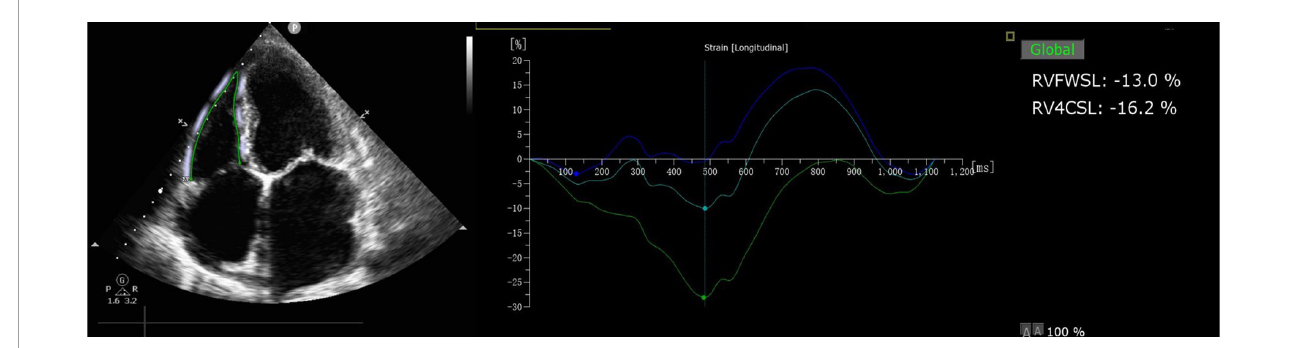
FIGURE2 RVFWSL and RV4CSL analysis. Offline analysis was performed using QLAB 10.3 software (cardiac motion quantification; Phillips Medical Systems) to analyze the longitudinal myocardial strain in the right ventricle. The longitudinal strain of the right ventricle was analyzed using the right ventricle as the main section, and the RVFWSL and the RV4CSL were